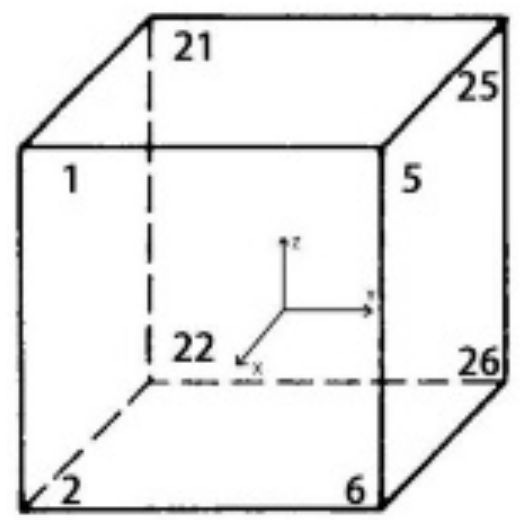
Figure 3. Model coding schematic diagram.